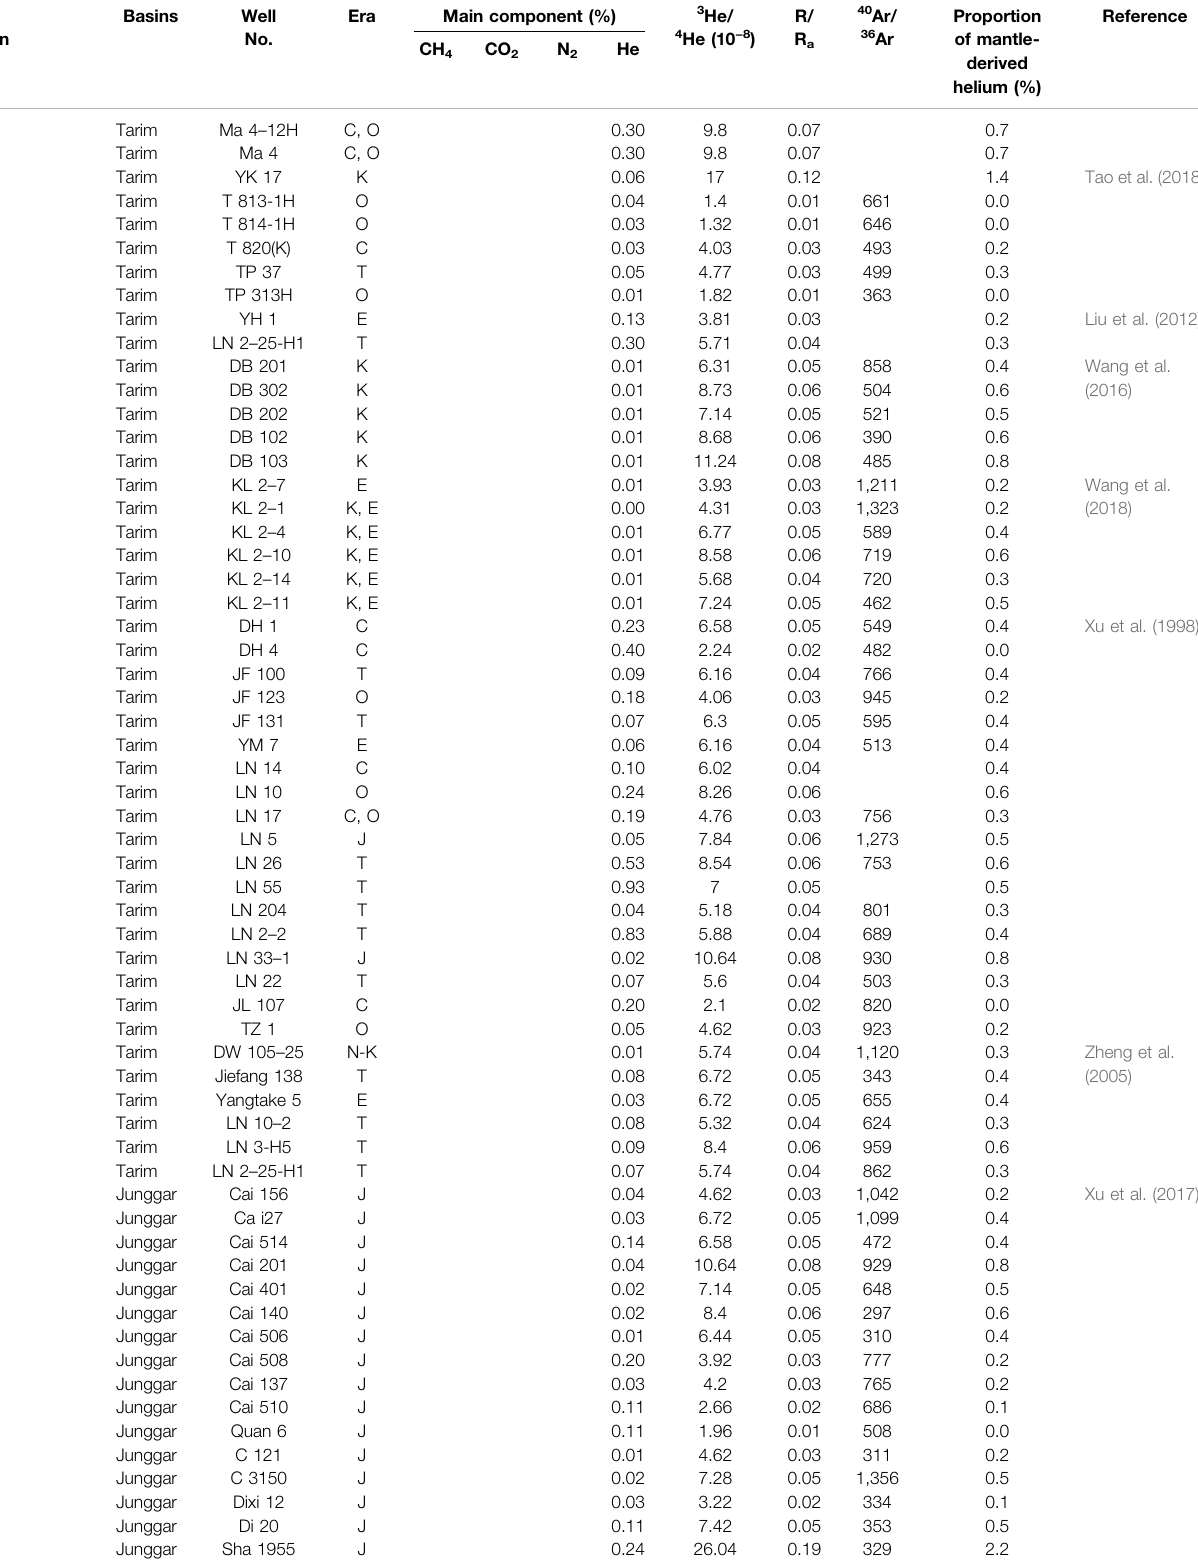
TABLE 1 | ( Continued ) Table of samples with helium content in some natural gas from petroliferous basins in China. Basin location